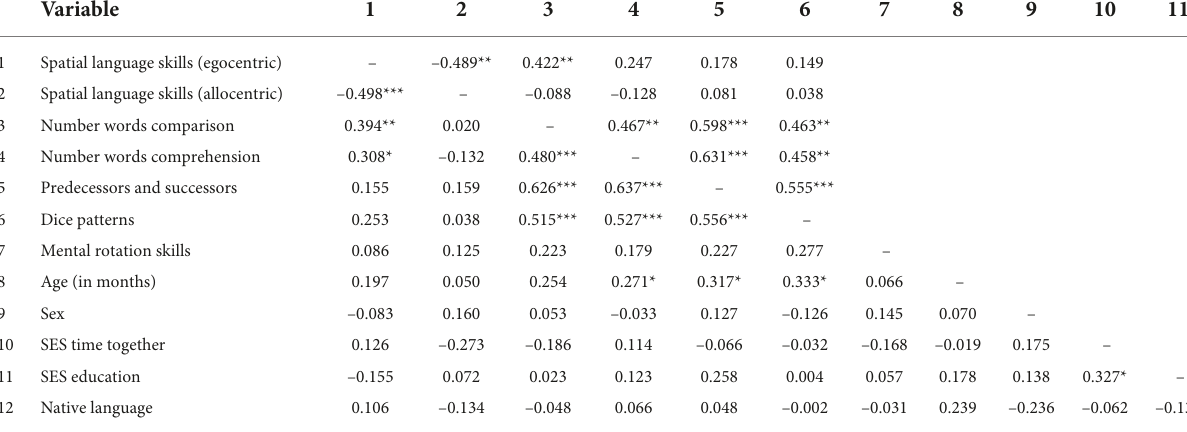
TABLE 3 Spearman correlation coefficients for the observed variables (below the diagonal) and partial pairwise spearman correlation coefficients (above the diagonal) taking into account the influences of the control variables mental rotation skills, SES, native language, age, and sex. Variable